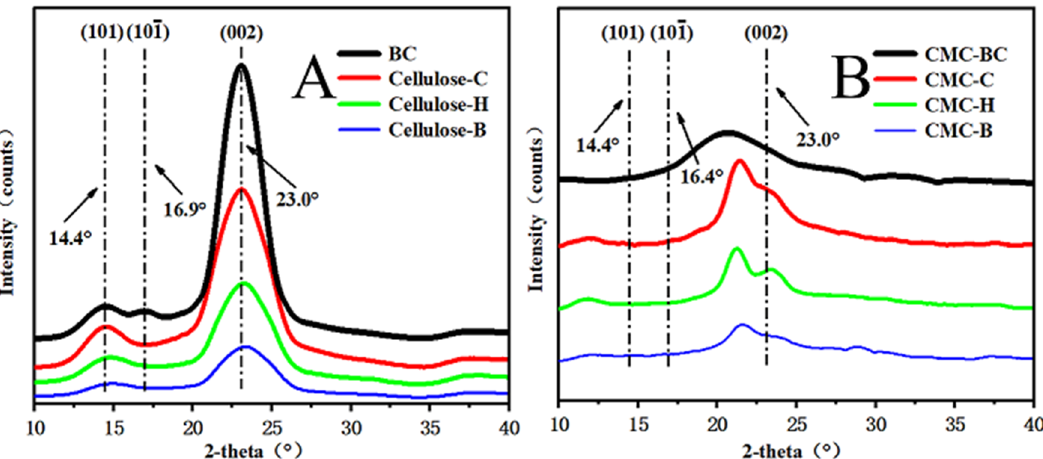
Figure 4. XRD spectrum of ( A ) BC and cellulose from Cryptomeria fortunei (Cellulose ‐ C), Hemp hurd (Cellulose ‐ H) and Bamboo (Cellulose ‐ B), ( B ) CMBC, CMC of cellulose from Cryptomeria fortunei (CMC ‐ C), Hemp hurd (CMC ‐ H) and Bamboo (CMC ‐ B).